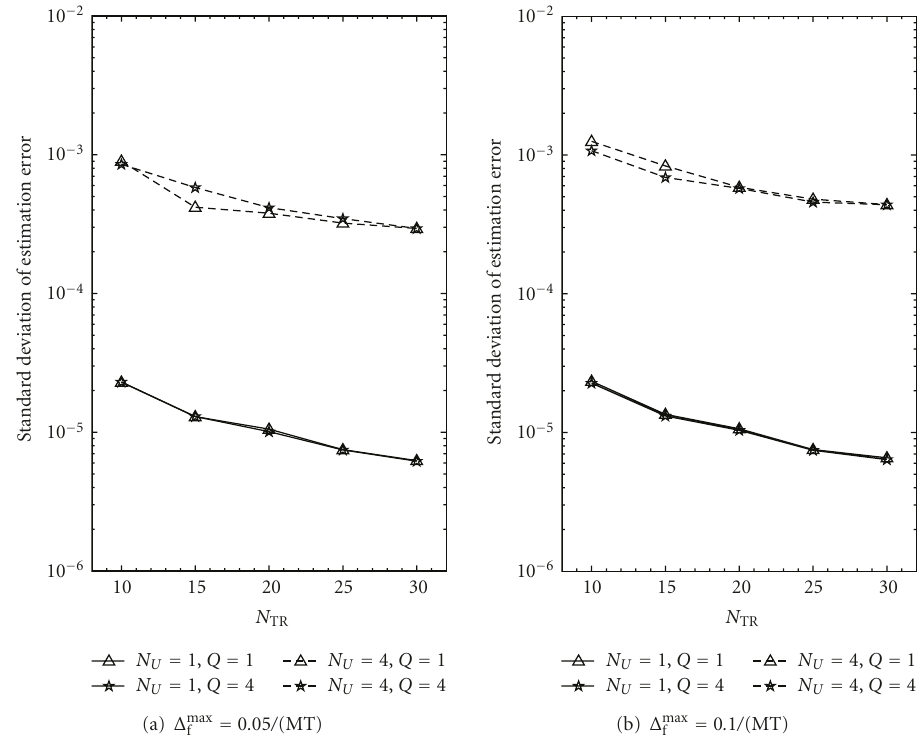
Figure 5: Standard deviation of the error in the frequency o ff set estimation as a function of the training sequence length. Metric (28) for FS-RX for di ff erent values of Δ max . SNR is equal to 20 f